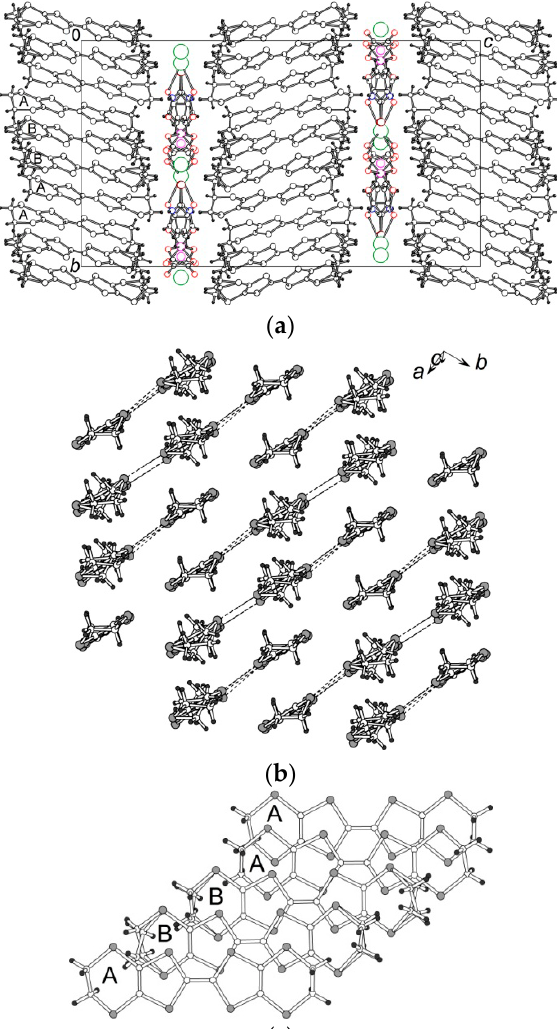
Figure 2. ( a ) Projection of the structure of 4 along a (the minor part of the [Ga(ox) 3 ] 3 − anion is omitted, except for Ga1B and K2 atoms); ( b ) view of the radical cation β ”-layer along the long axis of BEDT-TTF with short intermolecular S···S contacts < 3.6 Å (dashed lines); and ( c ) overlap modes within the stack.